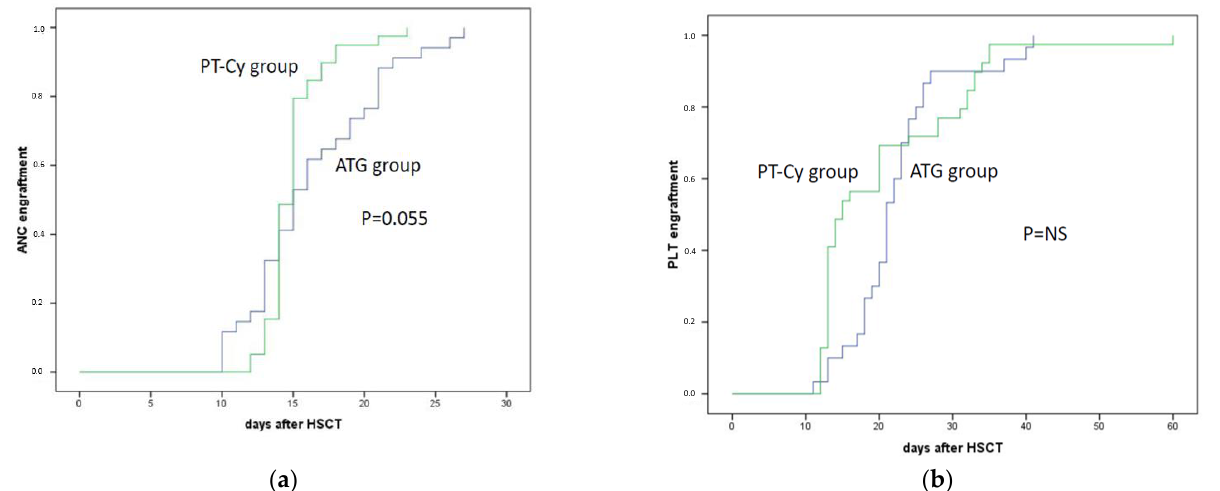
Figure 1. Neutrophil and platelet engraftment of patients treated with ATG (blue line) and with PT-Cy (green line). ( a ) Absolute neutrophil engraftment after mismatched unrelated donor transplantation ( p = 0.055); ( b ) platelets engraftment after mismatched unrelated donor transplantation.